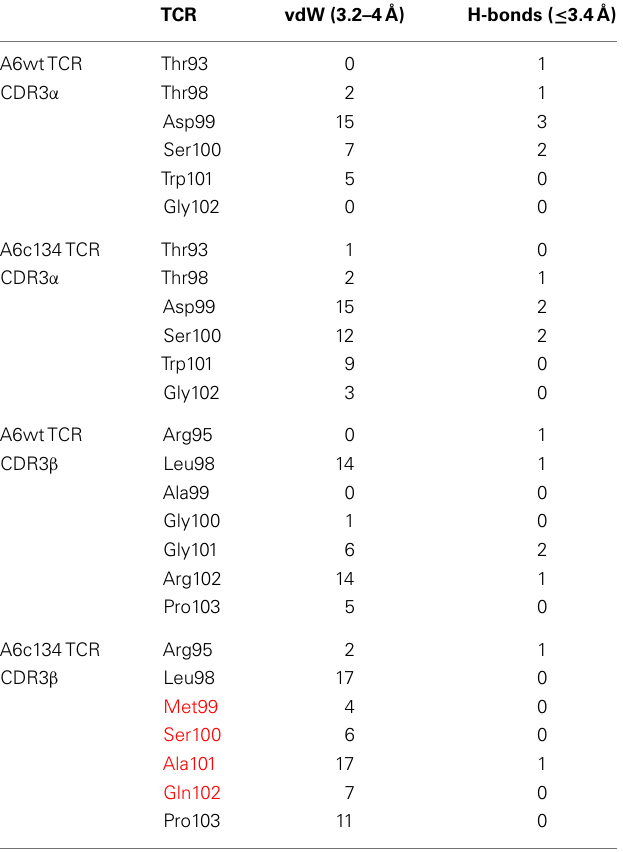
Table 2 | Direct contacts made by theA6wtTCR, orA6c134TCR CDR3 loops.